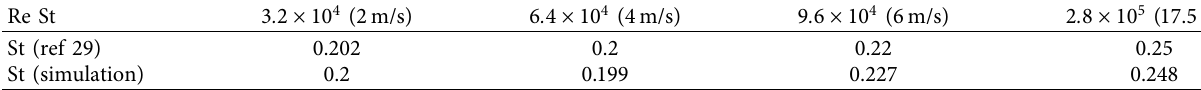
Table 6: Dimensionless parameter comparison.